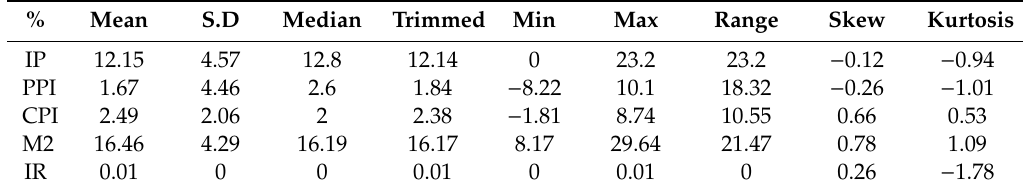
Table3. Summarystatisticsofmacroeconomicvariablesduringthecommoditiesfuturesresearchperiod.